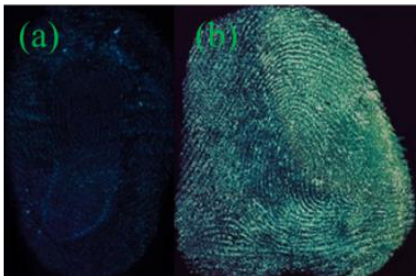
Figure 2. Diagrams of fingermarks on the tin foil paper after development using various quantum dots (QDs). ( a ) B-CDs; ( b ) G-CDs.